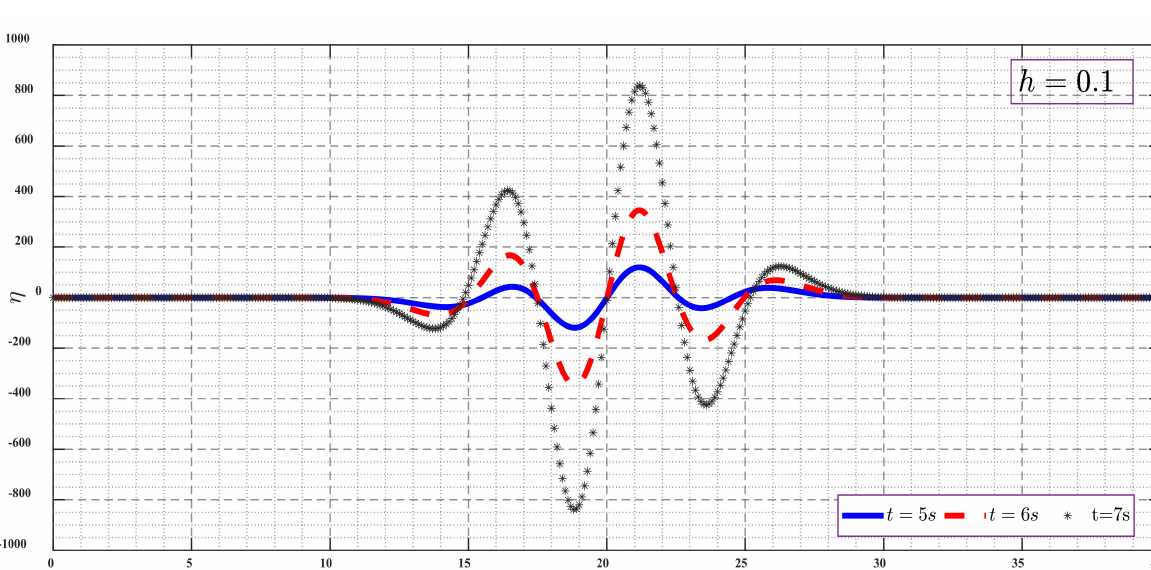
Figure 3. WSE ( η ) of SWWE at t = 5 s, 6 s, and 7 s ( h = 1.0 ).